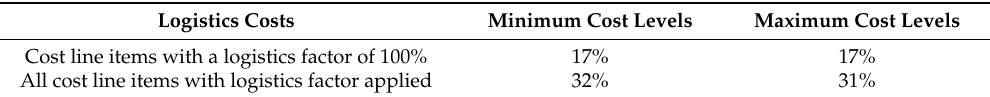
Table 7. The logistics costs share range of operational